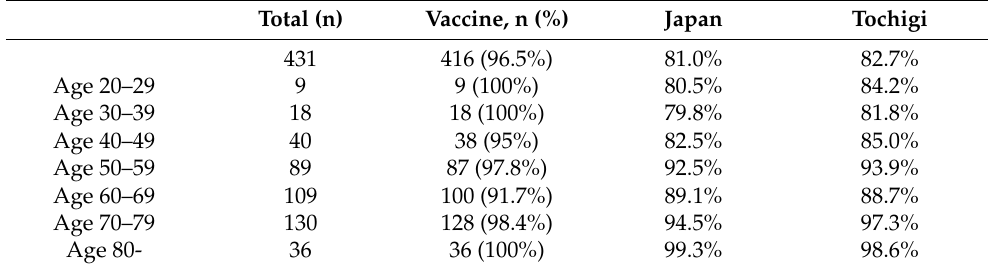
Table 1. The frequency of patients who received vaccine two times or more in each